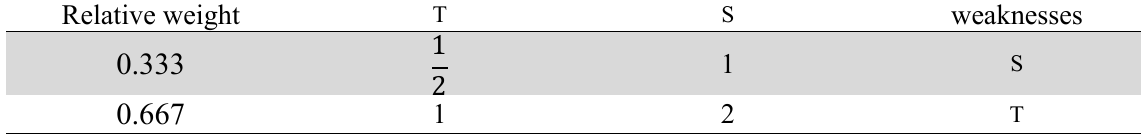
Interdependency matrix of SWOT factors given the weaknesses